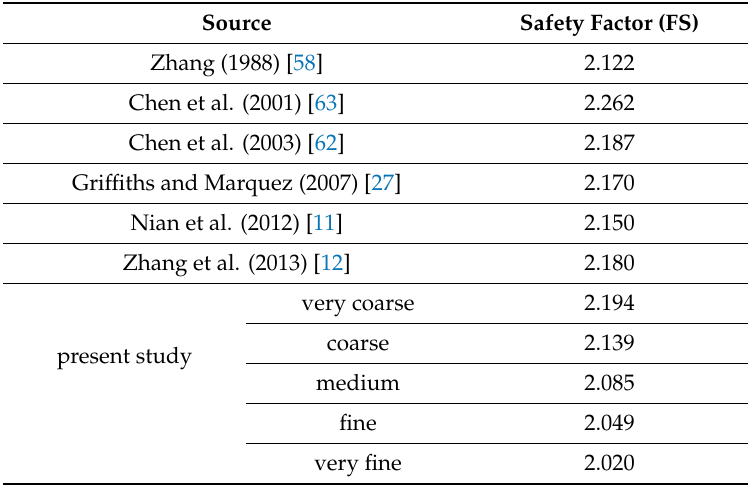
Table 1. Comparison of slope safety factors for